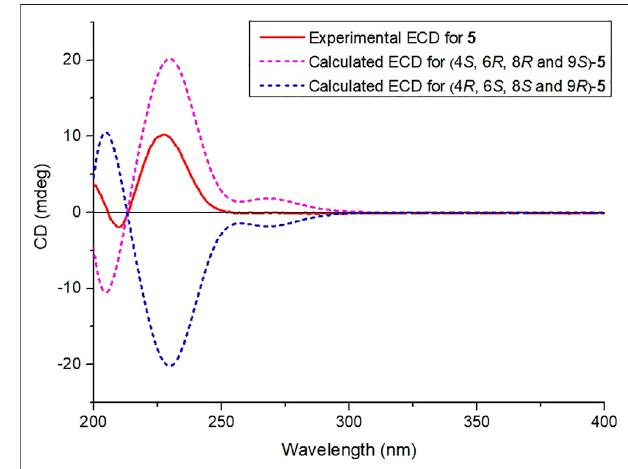
FIGURE 7 | Calculated and experimental ECD spectra of compound 5